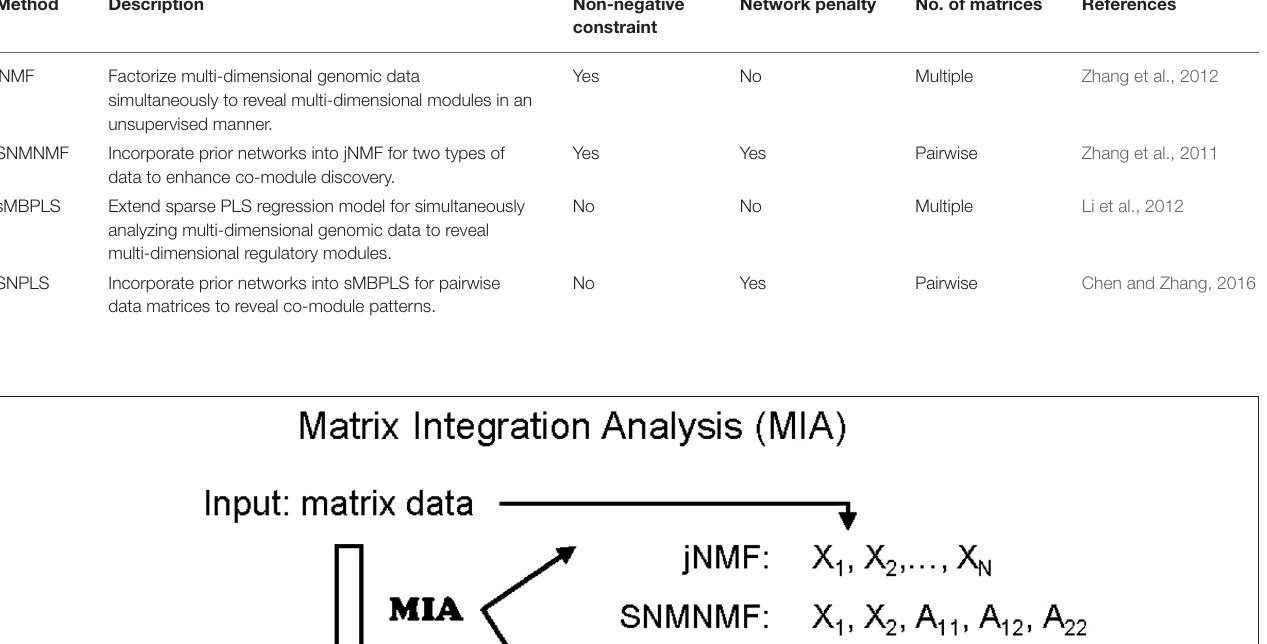
TABLE 1 | Brief summary of the four methods in MIA. Method